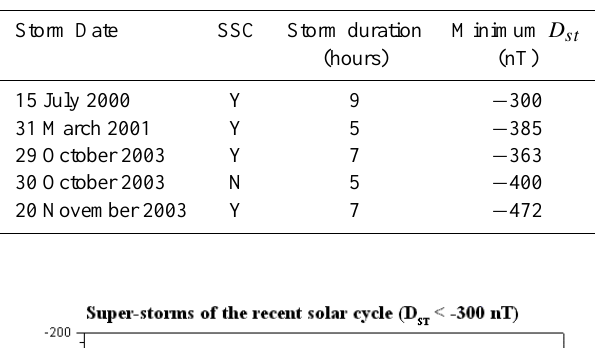
Table 4. Geomagnetic activity associated with events studied.